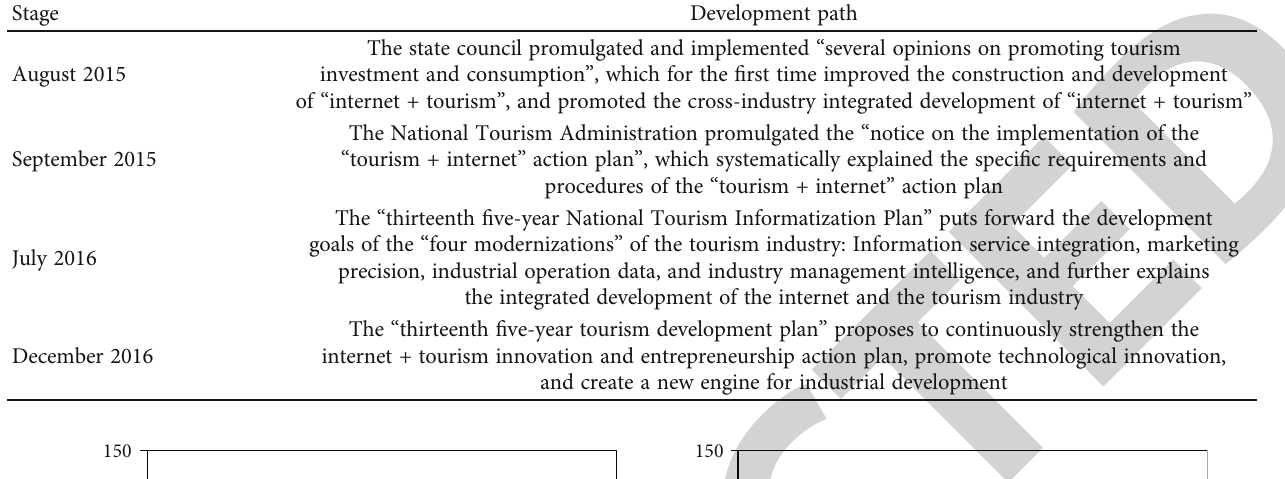
Table 1: Development history of “ Internet + Tourism ” .